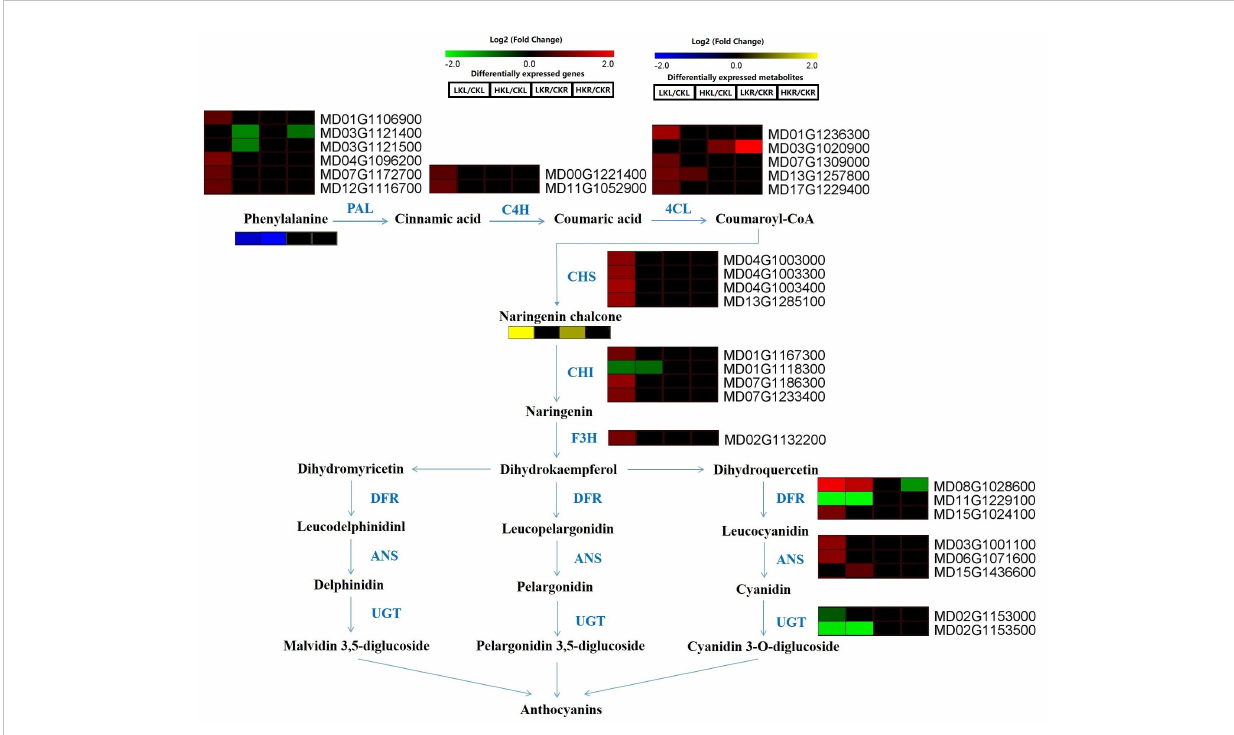
FIGURE 6 Flavonoid metabolites in apple leaves and roots under different K stresses. The boxes in the pathway represent DEGs or DAMs. Red and green represent upregulated and downregulated genes, respectively. Yellow and blue represent upregulated and downregulated metabolites,